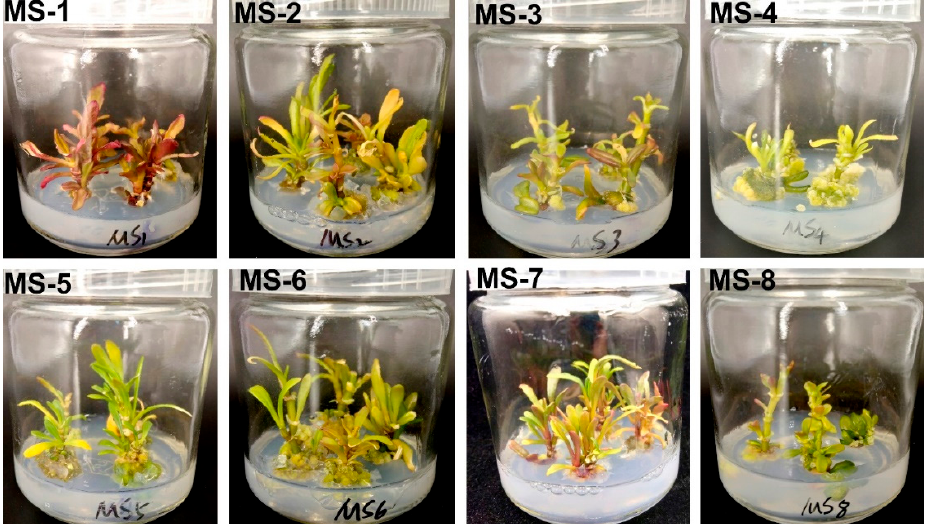
Figure 2. Effect of different growth regulator combinations (see Table 1) on induction of axillary shoots from nodal explants of S. portulacastrum cultured on MS medium. The photos were taken after eight weeks of culture (photos for MS 9 and MS 10 are not shown).